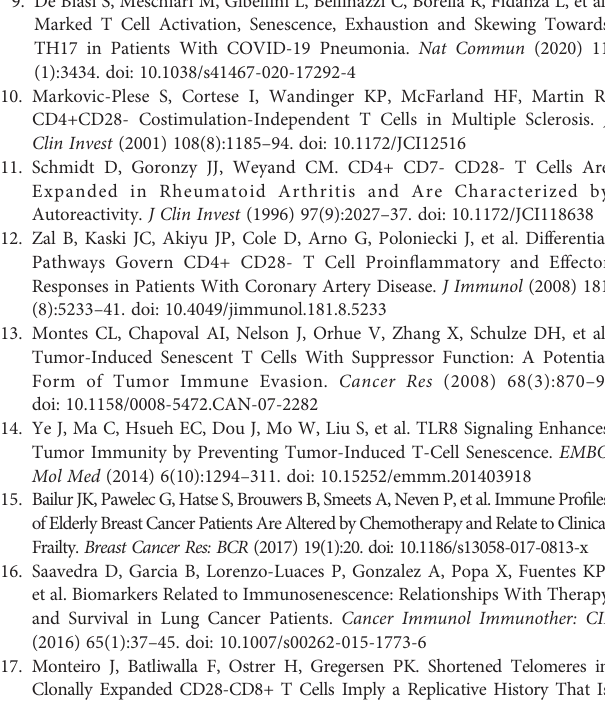
Supplementary Table 2 | List of antibodies used for fl ow cytometry staining in the manuscript. Supplementary Figure 1 | Senescent CD4 + T cells do not proliferate. Representative zebra plots from sorted KLRG-1 − CD57 − , KLRG-1 + CD57 − and KLRG-1 + CD57 + CD4 + T cells from peripheral blood of breast cancer patient show the frequency of Ki-67 + cells after 72 h of anti-CD3/CD28 stimulation. Supplementary Figure 2 | KLRG-1 + CD57 + CD8 + cells from peripheral blood exhibit features of senescence. (A) Pie charts exhibit proportion of CD27 + CD28 + (white),CD27 + CD28 − (lightgray),CD27 − CD28 + (darkgray)andCD27 − CD28 − (black) within CD8 + T cell subpopulations de fi ned by the expression of KLRG-1 and CD57, for all HDs and BC patients analyzed. (B) Bar graph shows frequency of